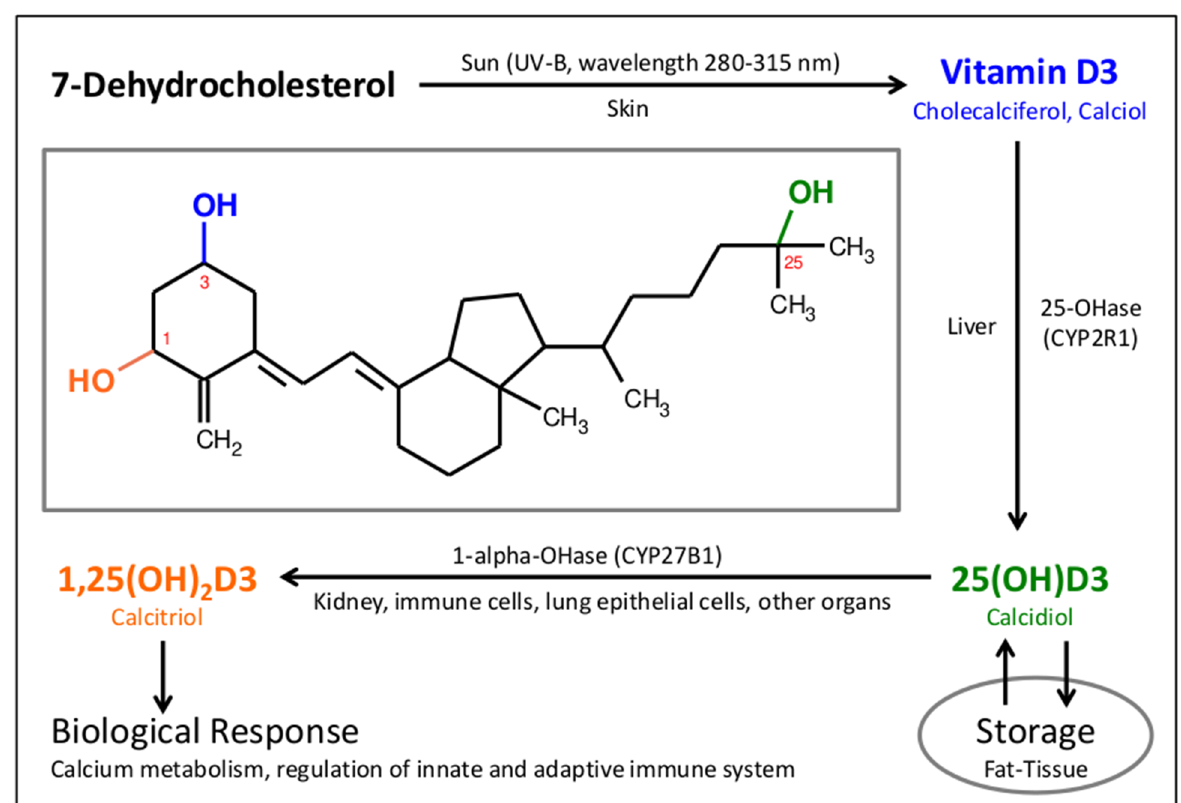
Figure 1. Metabolic pathway of vitamin D3: The chemical formula of calcitriol is used to illustrate the biochemistry of vitamin D and its metabilites using different colors. The vitamin D pathway is characterized by two subsequent hydroxylation steps. In the liver, 25-Hydroxylase produces 25(OH)D3 (calcidiol), which can be stored in fat tissue. 1-Alpha-hydroxylase generates the active steroid hormone 1,25(OH)2D3 (calcitriol), which regulates calcium metabolism as well as the innate and adaptive immune system.